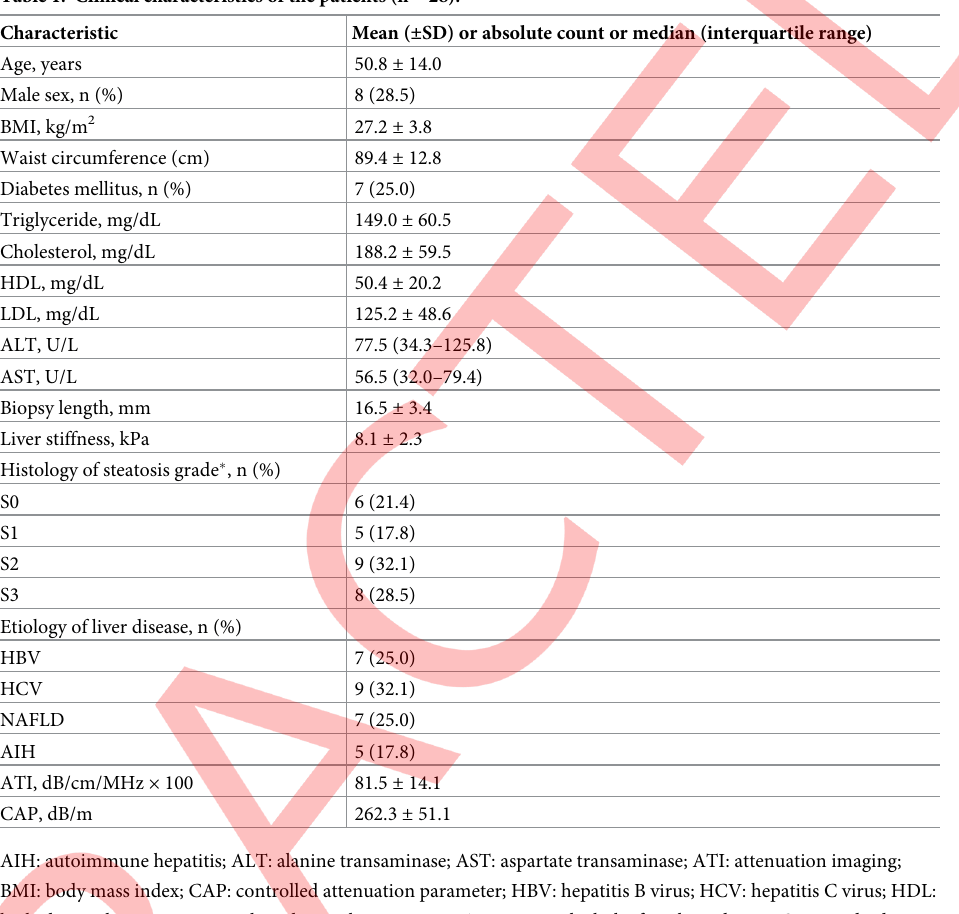
Table 1. Clinical characteristics of the patients (n =